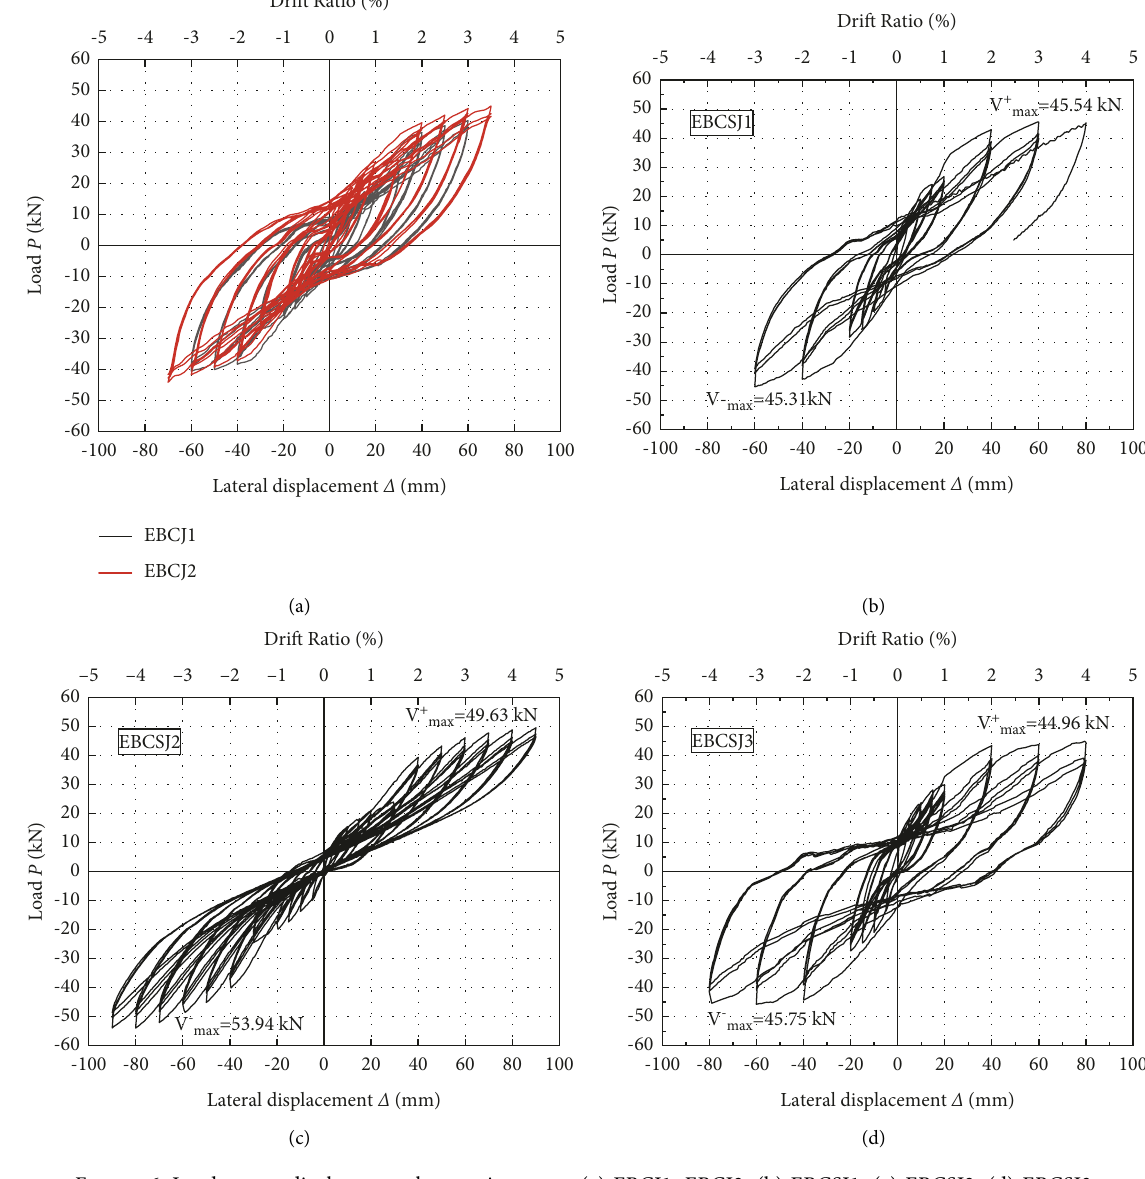
Figure 6: Load versus displacement hysteretic curves. (a) EBCJ1, EBCJ2. (b) EBCSJ1. (c) EBCSJ2. (d)